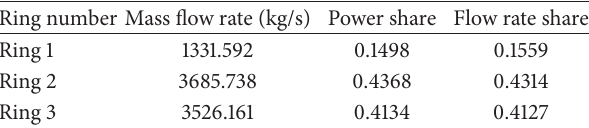
Table 4: Mass flow rate, power distribution factor, and flow distribution factor of each fuel